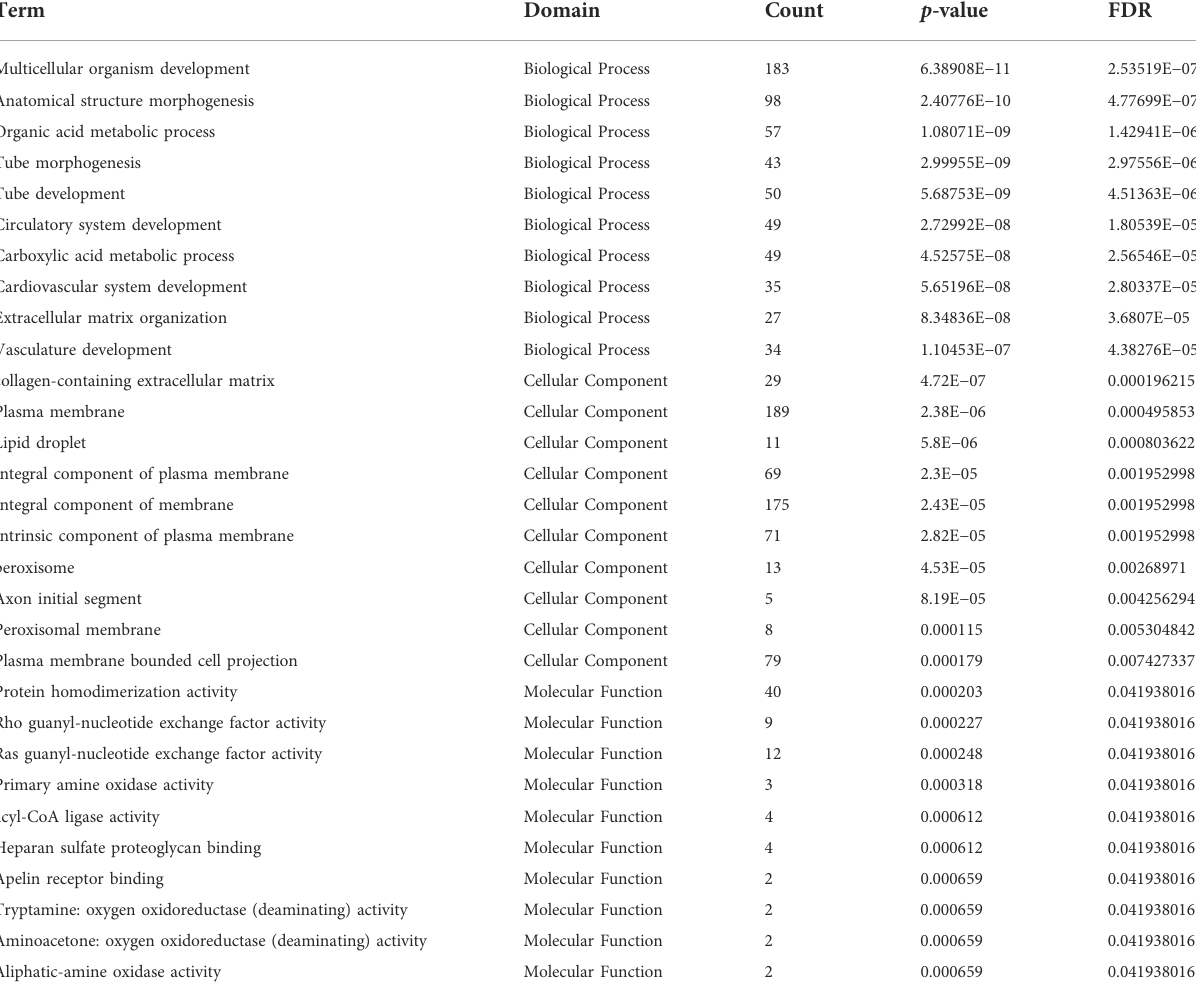
TABLE 3 Go analysis of the top 10 mRNA expression with largest signi fi cant difference in three domains.